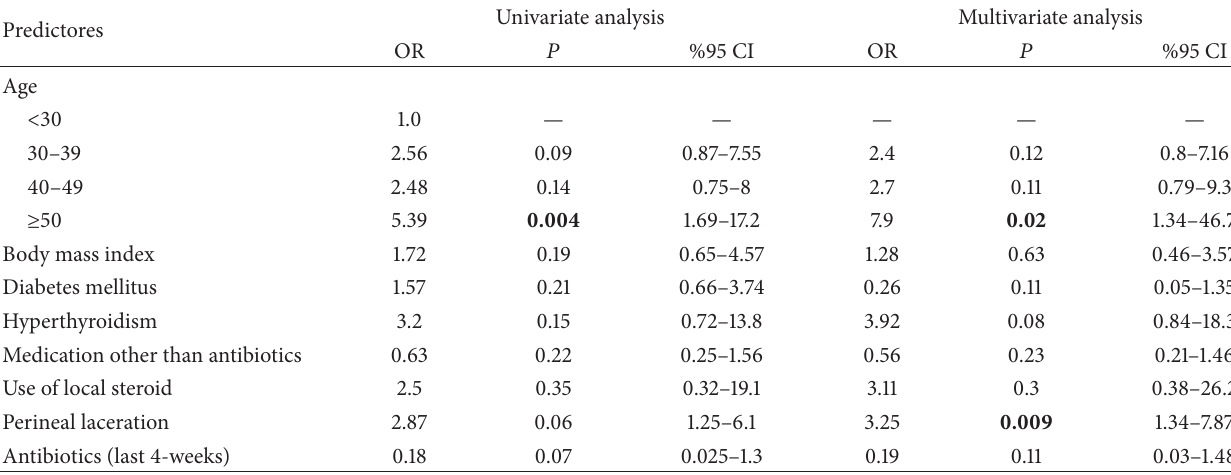
Table 3: Analysis of predictive factors for Candida krusei infection using univariate and multivariate logistic analyses.